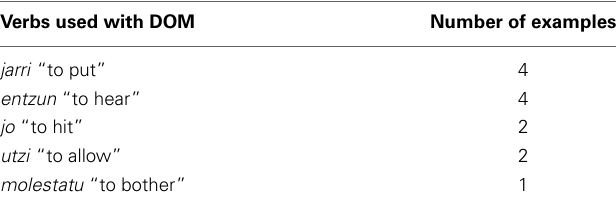
Table 7 | Use of DOM in Basque (bilingual